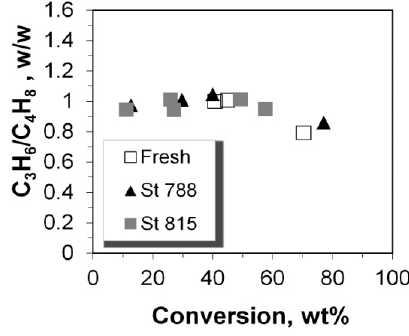
Figure 9: Production yields of ( a ) propylene and ( b ) total butylenes versus the conversion of n-C 12 .